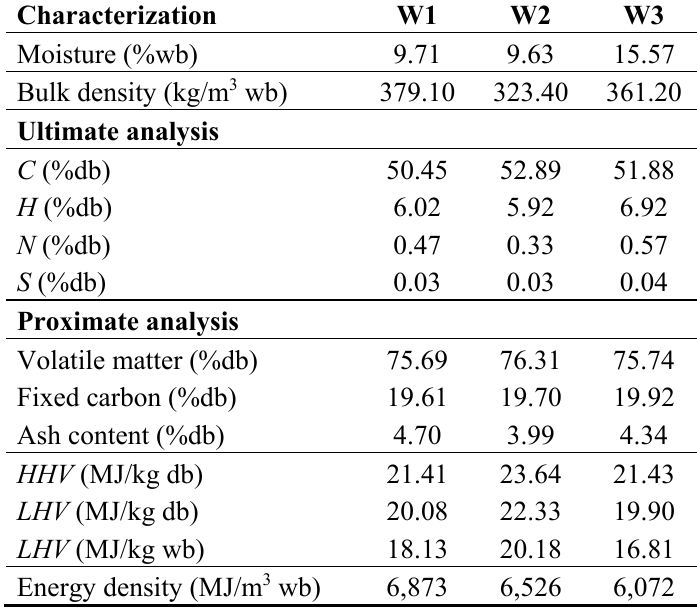
Table 3. Raw material characterization. W1, waste product 1. wb, wet basis; db, dry basis; HHV , high heating value; LHV , low heating value.